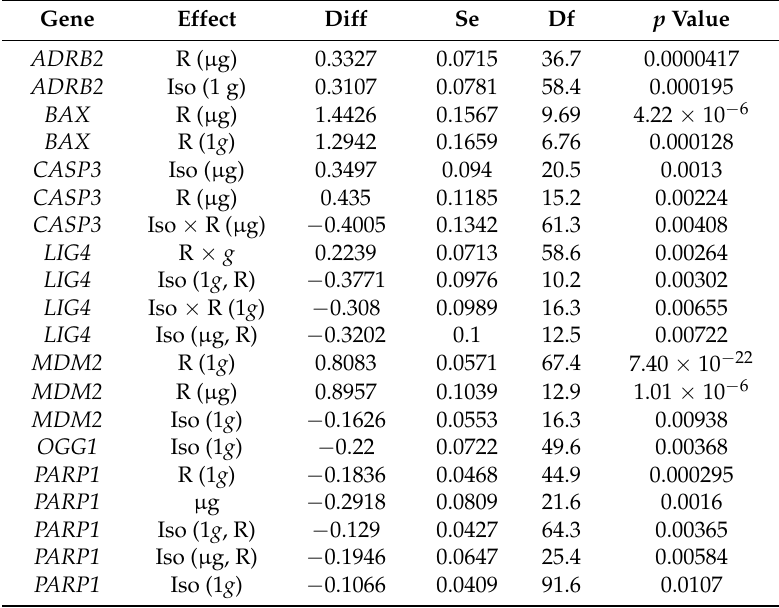
Figure 3. Radiation effects on gene expression relative to non-irradiated cells incubated in ( A) 1 g and ( B ) µg. Cells were irradiated either with 0.8 Gy (light bars) or 2 Gy (dark bars) and immediately incubated in 1 g (grey bars) or µg (blue bars) for 24 h. Error bars represent SEM. Asterisks represent significant differences in gene expression in cells irradiated with 0.8 Gy compared to cells irradiated with 2 Gy. Statistical method: Krieger. p -value threshold: 0.018 after controlling the FDR (false-discovery rate—see statistical methods) to 5%. Table 2. Significant differences in mean transformed gene expression (0.8 Gy). Effects listed below are described in Table 7.